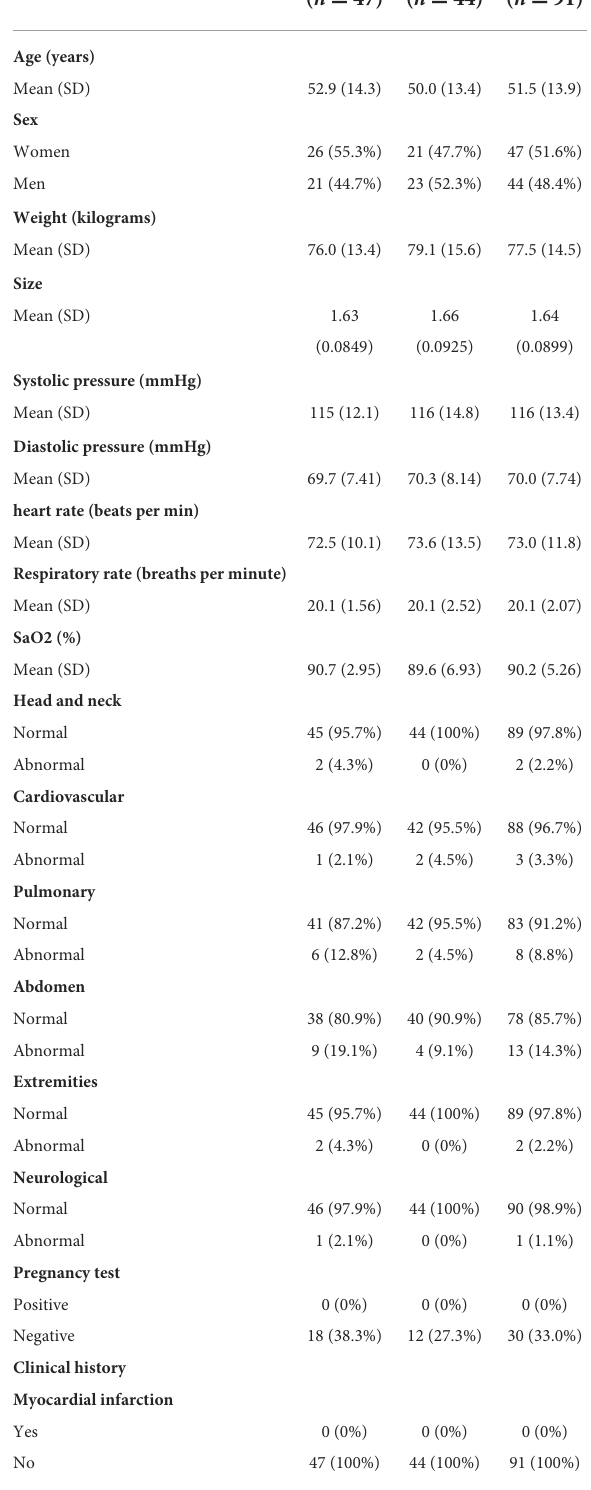
TABLE 1 Demographic and clinical history for the patients enrolled in CS002-COVID19. Demographic